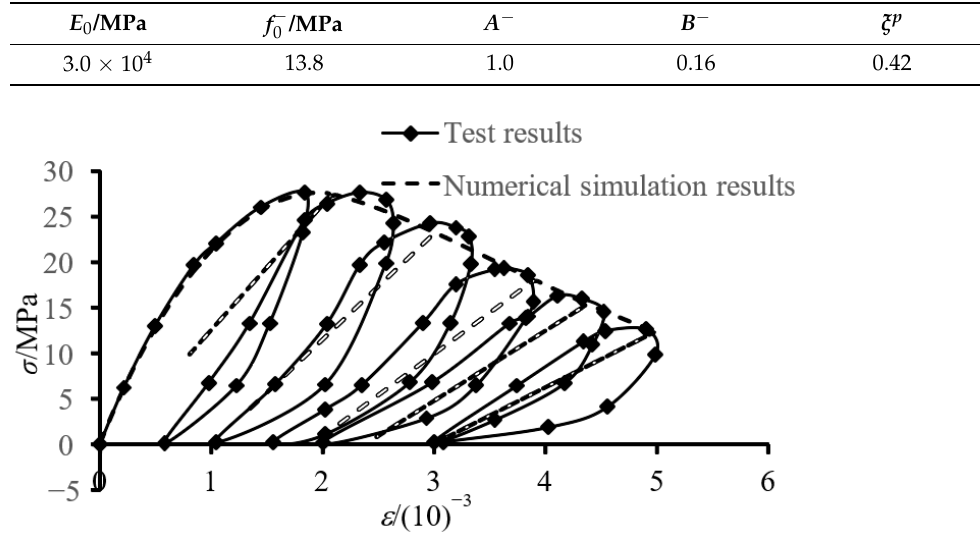
Figure 5. Comparison of numerical simulation result and experimental result (cyclic compression test).